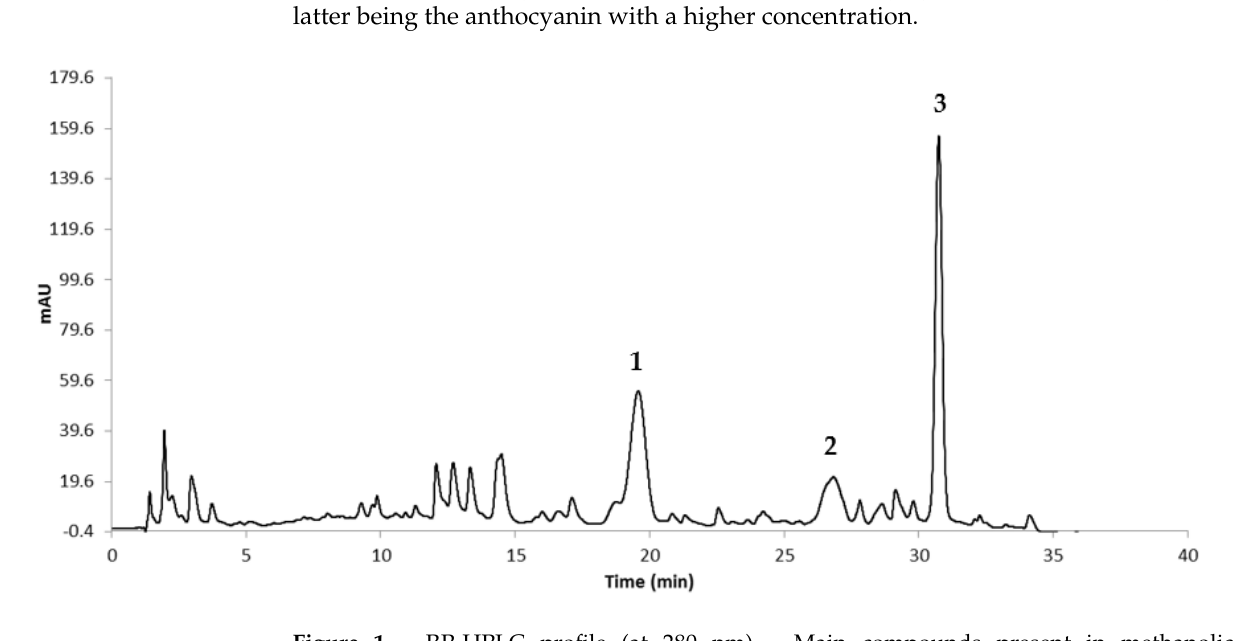
Figure 1. RP-HPLC profile (at 280 nm). Main compounds present in methanolic ex- tract from grape